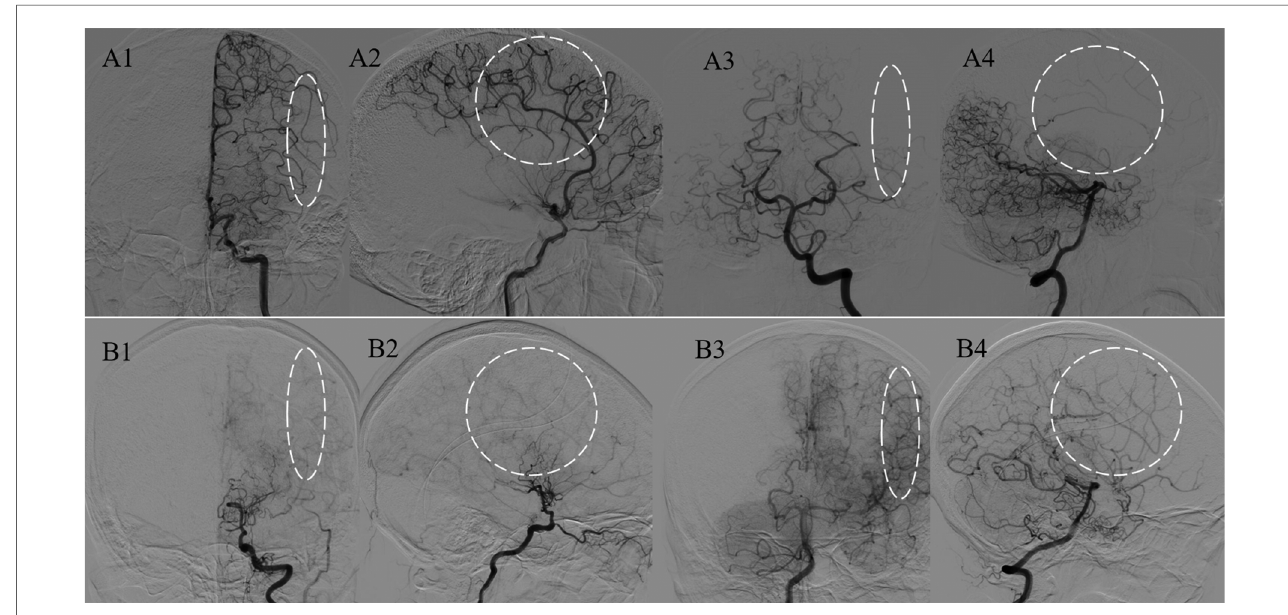
FIGURE 2 Analysis of the major blood sources of the PSCAs. Representative fi gures of M-PSCAs and non-M-PSCAs, which are de fi ned as the PSCAs (white circles and ovals) with blood fl ow from the MCA and non-MCAs. Panels A1 – 4 indicate the major hemodynamic sources of PSCAs originating from the MCA; B1 – 4 indicate those from the posterior cerebral artery